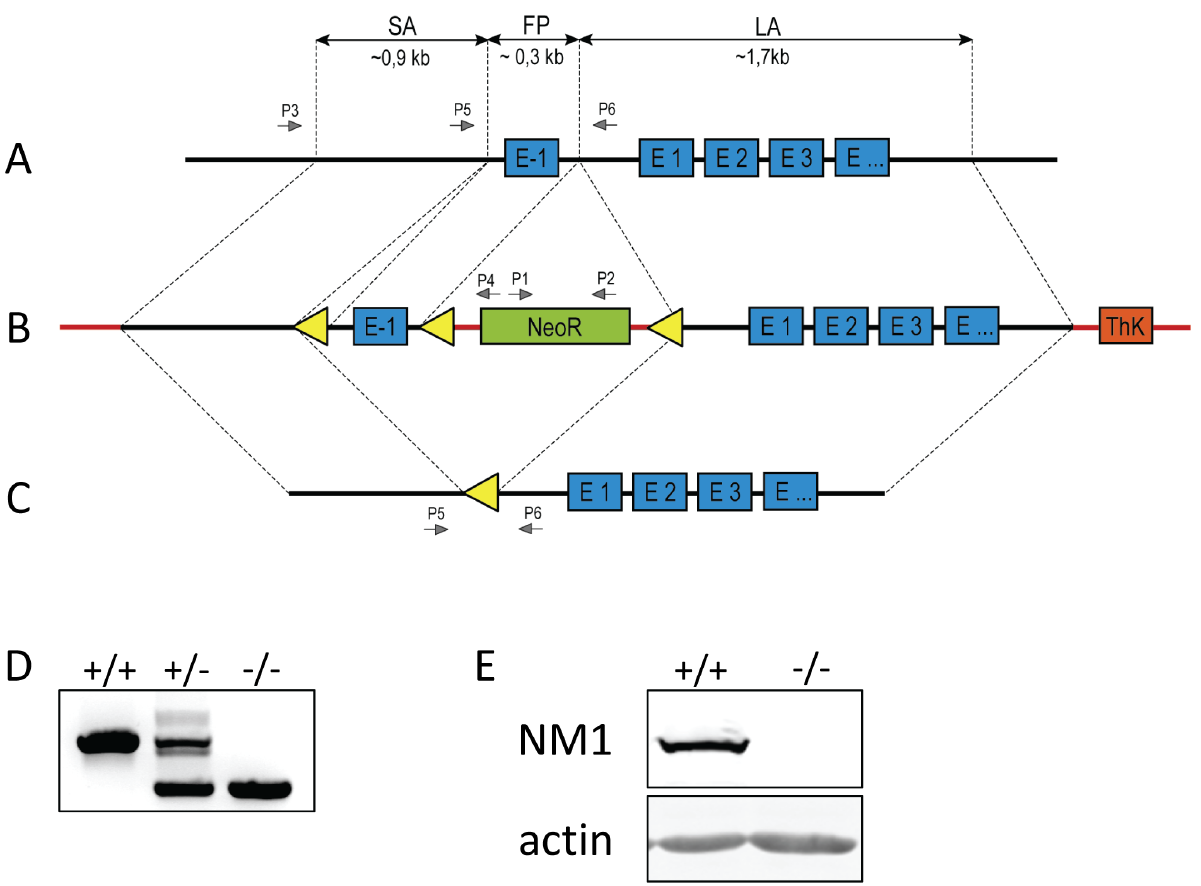
Figure 1. Preparation of NM1 knock-out cassette. ( A ) WT genomic locus of Myo1c gene. Short homology arm (SA), floxed part (FP), and long homology arm (LA) of appropriate length (0.9; 0.3; 1.7 kb respectively), were cloned to pEasyFlox vector carrying neomycin (NeoR) and thymidine kinase (ThK) selection genes ( B ). Black lines represent genomic sequences; red line represents sequences derived from pEasyFlox vector. ( B ). ( C ) Genomic loci of Myo1c gene with excision of exon -1; P1 – P6 represent different primers needed for genotyping of ES cells and knock-out mice, yellow triangles represent loxP recombination sites. ( D ) Genotyping of NM1 knock-out mice by PCR. P5 and P6 primers were used to distinguish between wild type ( + / + ), heterozygous ( + / 2 ) and knock-out ( 2 / 2 ) animals. ( E ) Western blot analysis of NM1 levels in NM1 wild type ( + / + ) and knock- out ( 2 / 2 ) mice. Fifteen micrograms of protein per lane was loaded, and probed for NM1. Equal loading was monitored by Coomassie Brilliant Blue staining of the band corresponding to actin. doi:10.1371/journal.pone.0061406.g001 For testing of interchangeability of the two myosin isoforms, stable knock-down of human NM1 and Myo1c with exogenous